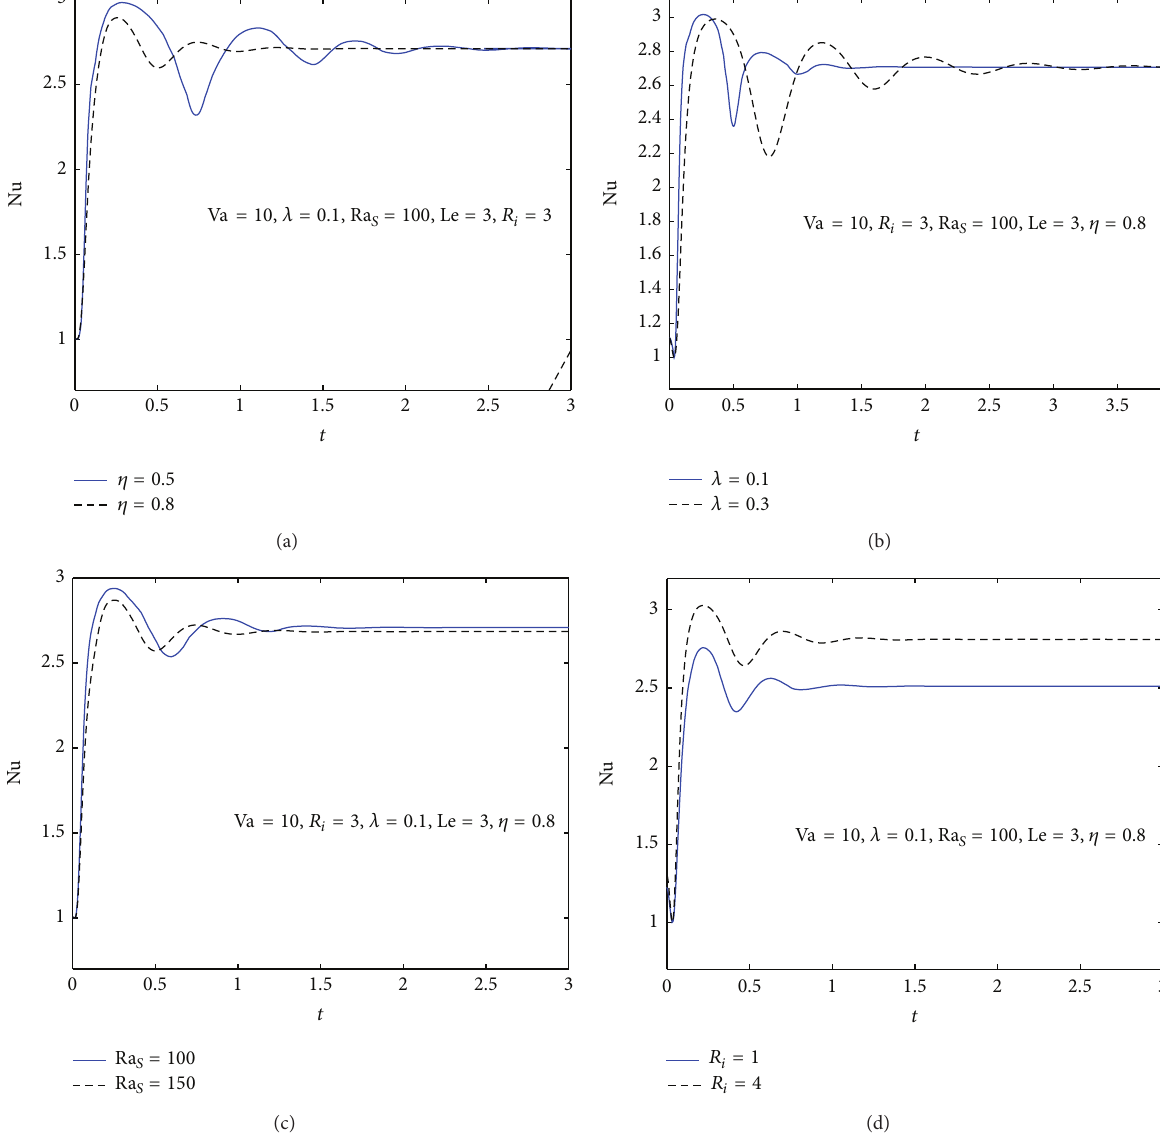
effect of the increasing Va is to stabilize the system.